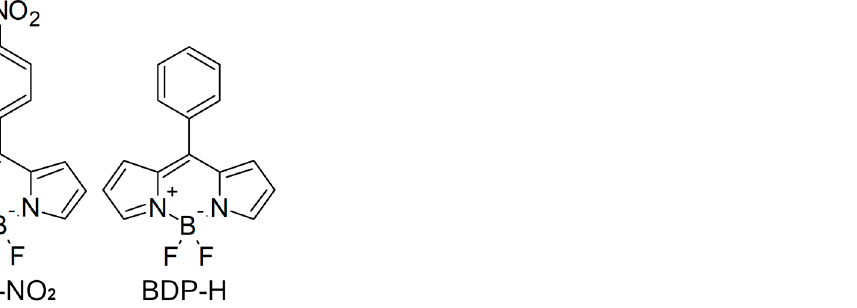
Figure 1. The molecular structures of BDP-NO 2 and BDP-H molecular rotors examined in this work.